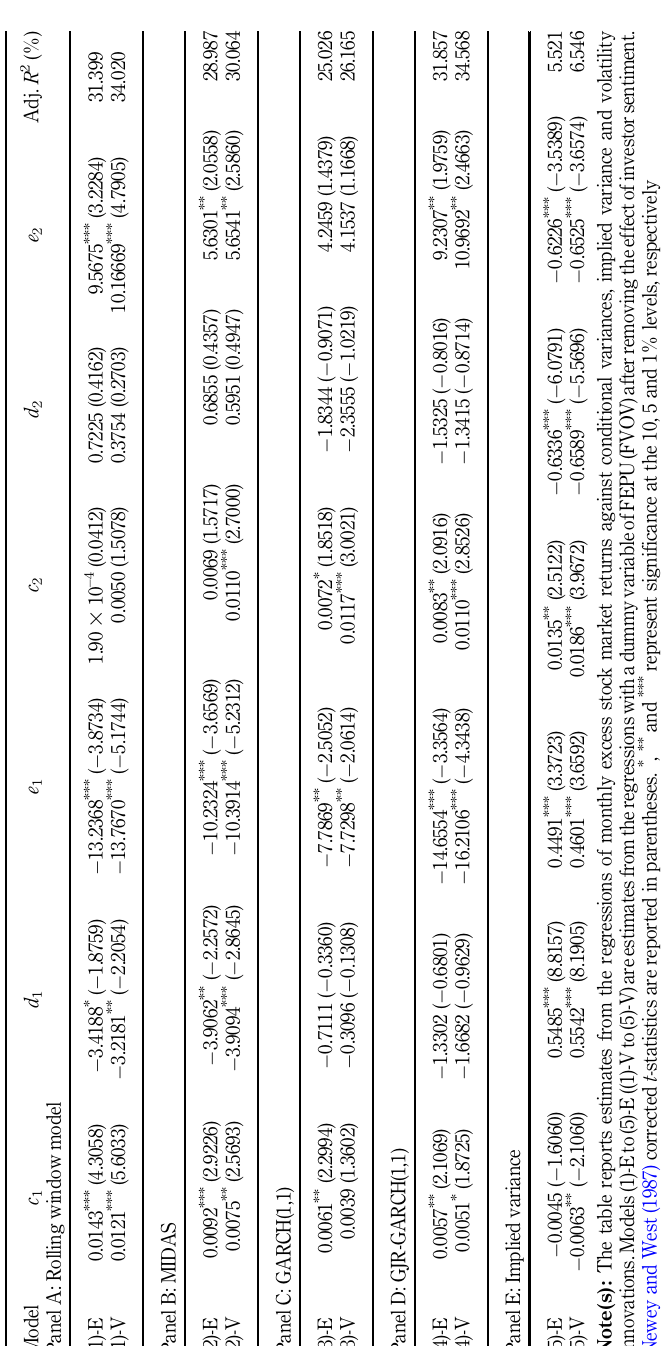
Table 8. Removing effect of investor sentiment: Monthly excess stock market returns against conditional variances, implied variance and volatility innovations with